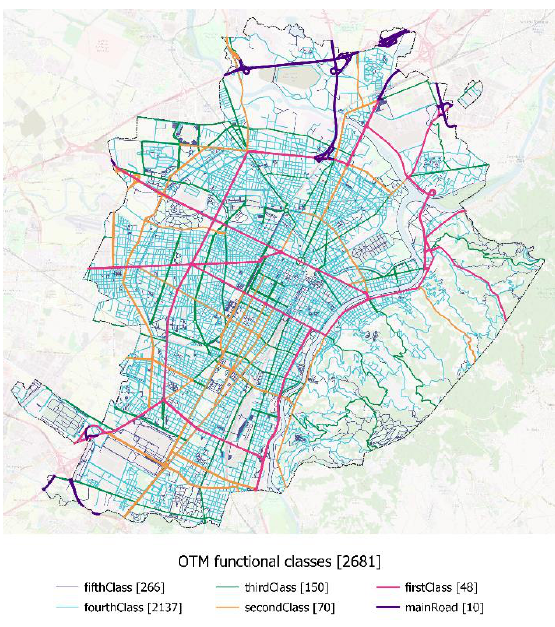
Figure 3 – OTM functional classes in the city of Torino (in square brackets the number of network elements in each